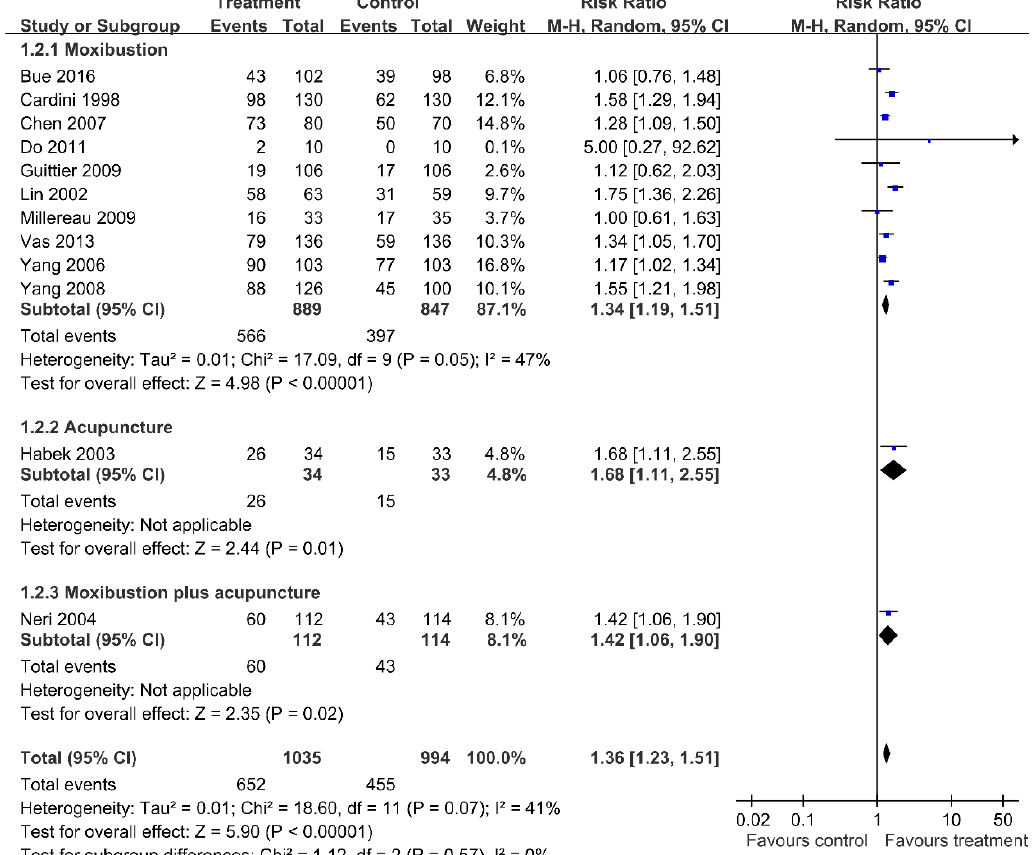
Healthcare 2021 , 9 , x Figure 5. Sensitivity analysis: Acupuncture-type interventions versus Control; Outcome: Cephalic presentation.